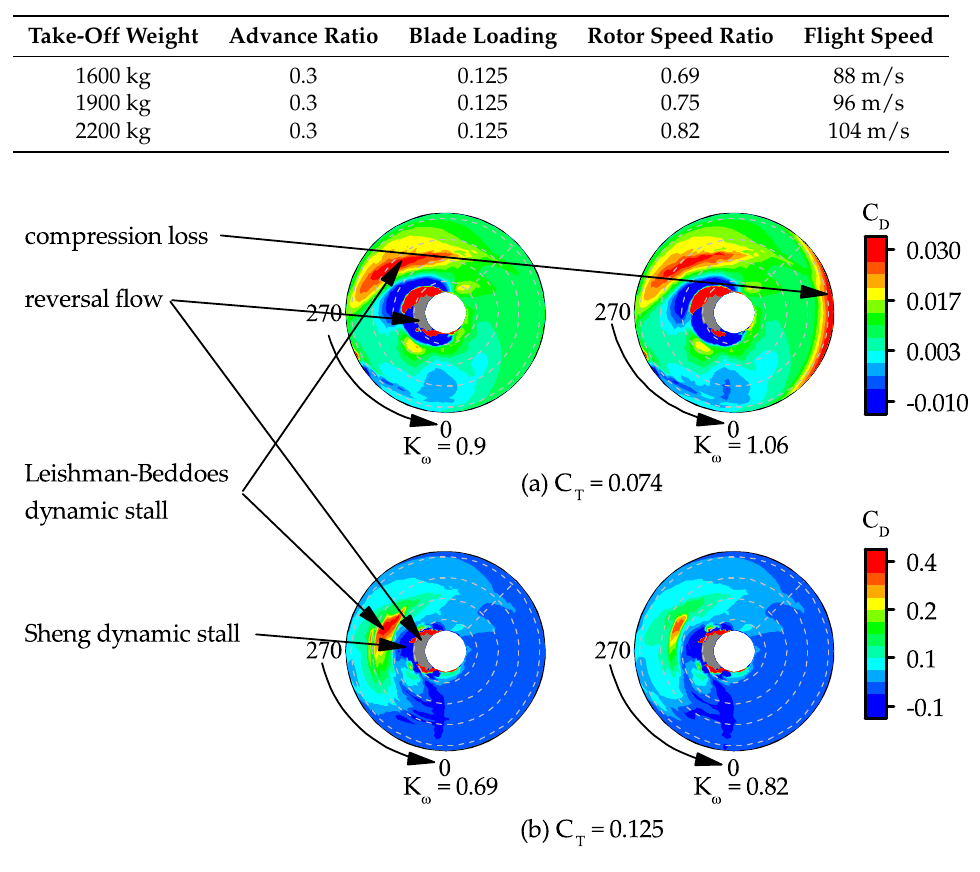
Figure 14. Drag coefficient, C D , with rotor speed for different rotor